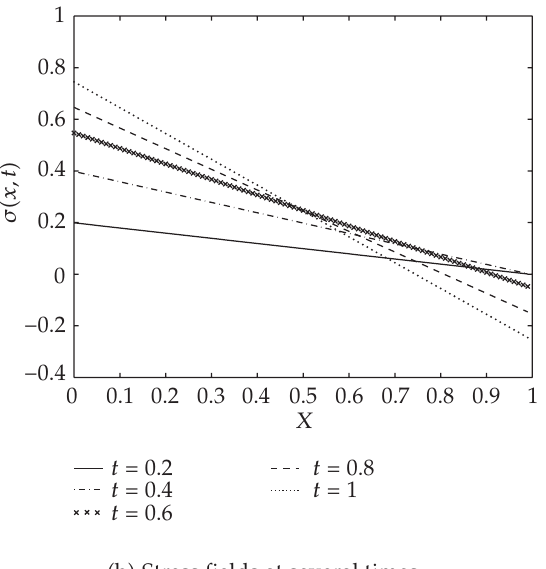
Figure 4.2 . Problem 4.1: displacement and stress fields for di ff erent time